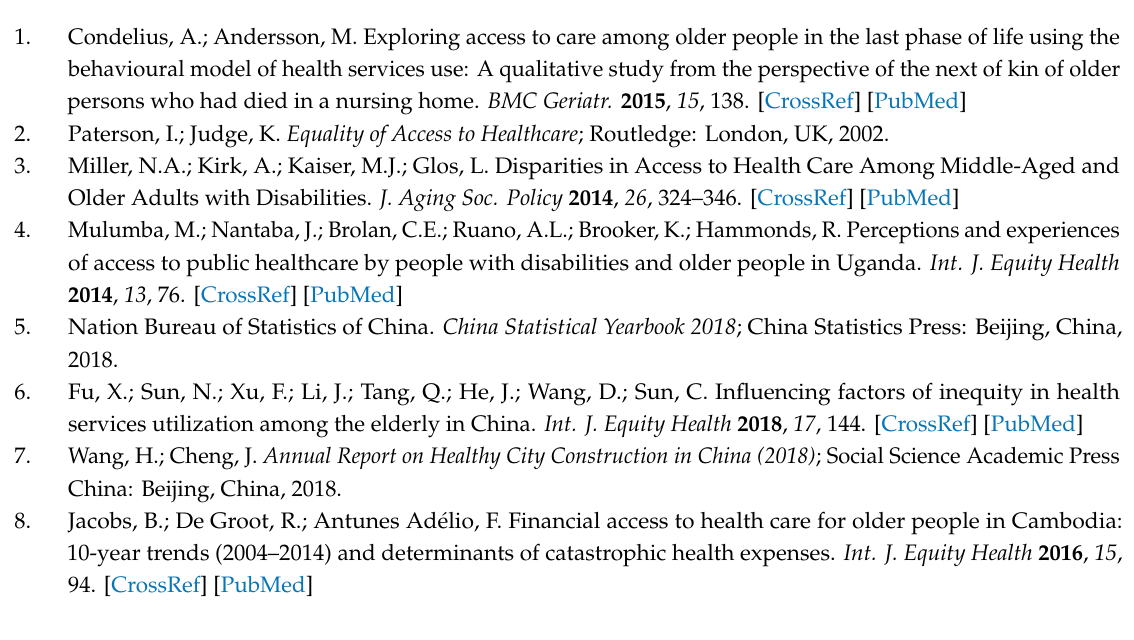
Table S1: Aggregate decomposition of the change in perceived accessibility to healthcare (excluding the 290 repeated respondents), Table S2: Distributional and coe ffi cient e ff ects of explanatory variables on the change in perceived accessibility to healthcare (excluding the 290 repeated